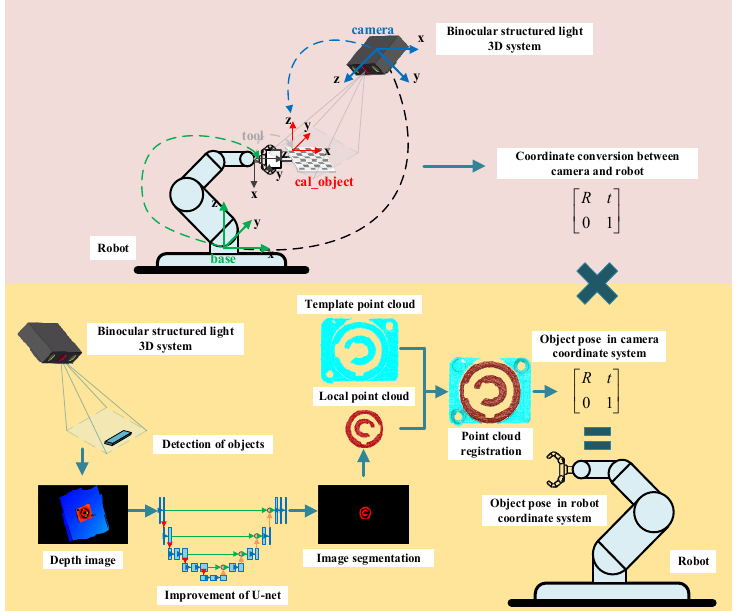
Figure 1. Workflow of automatic robotic assembly system. The transformation relationship between the robot and the camera is obtained through hand–eye calibration. Through point cloud segmenta- tion and point cloud registration, the pose of the target in the camera coordinate system is calculated. The hand–eye transformation matrix is multiplied by the pose of the target in the camera coordinate system to obtain the pose of the target in the robot coordinate system, which realizes automatic assembly guidance of the